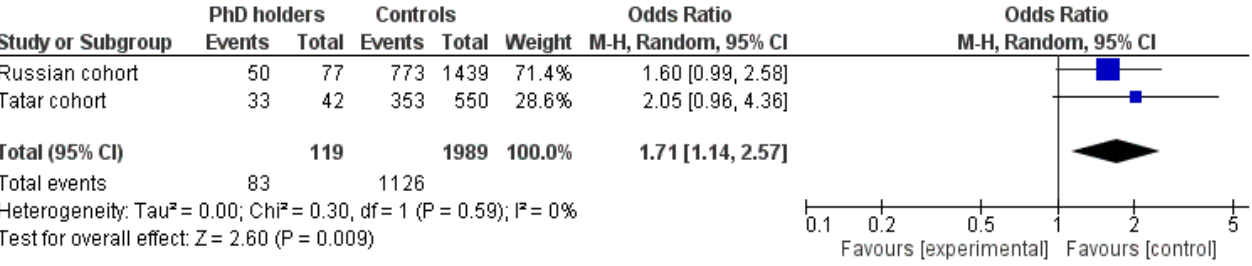
Figure 3. Meta-analysis for association studies for the KIBRA gene and PhD status. The prevalence of the rs17070145 CT/TT genotypes has been shown in PhD holders. The purple squares represent the ratio of CT/TT genotypes in PhD holders for each individual study. The black diamond represents the pooled ratio of CT/TT genotypes in all PhD holders and its 95% CI.